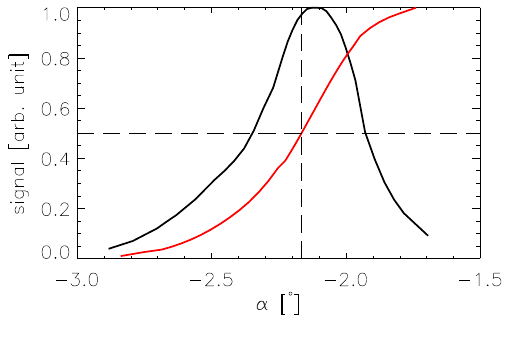
Fig. 4. Field-of-view of the Mini MAX-DOAS instrument, mea- sured with the set-up of Fig. 3. The black curve represents the mea- sured signal at elevation α , and the red curve is the normalized sur- face integral of the black curve. The FWHM is 0.4 ◦ . The center of the field-of-view is defined as the elevation where the red curve equals one half. In this case the pointing offset is − 2.16 ◦